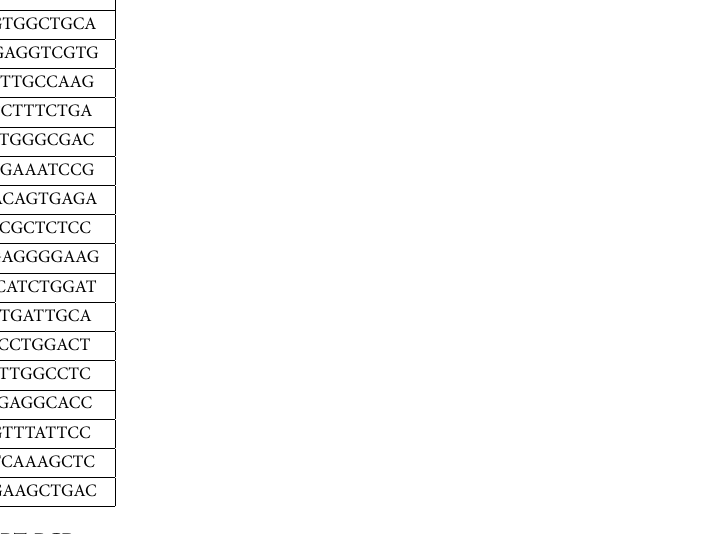
Table 2. Primer sequences for